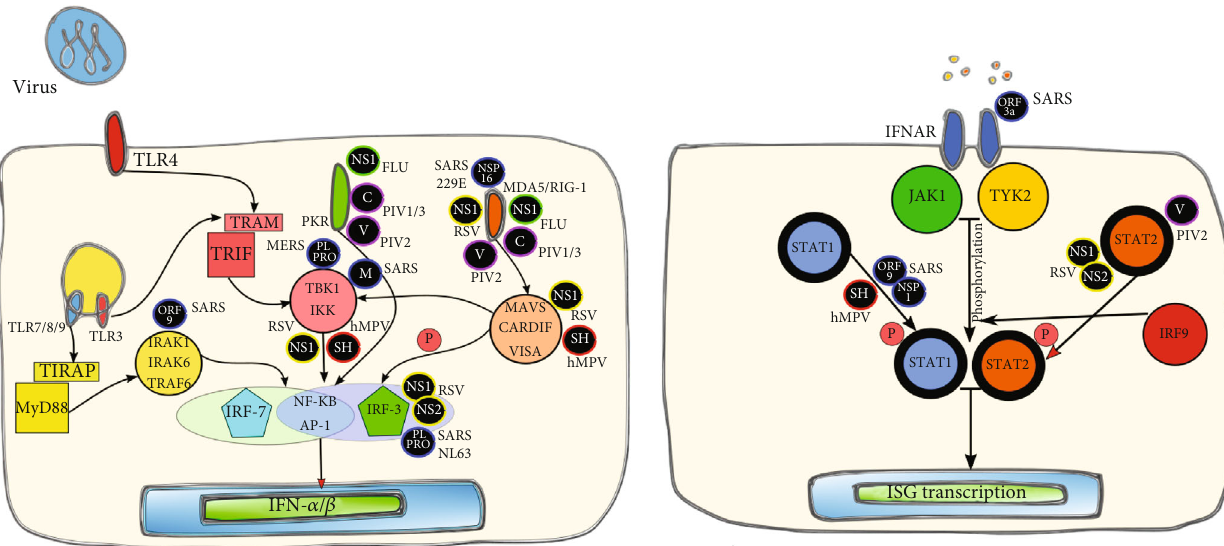
Figure 3: Evasion and inhibition of respiratory virus-induced IFN-I signaling. Many respiratory viruses can inhibit and modulate their detection using diverse strategies, thereby inhibiting the IFN-I production. Circular boxes in black background represent the viral protein involved in the pathway inhibition. Abbreviations: NS: nonstructural protein; V: V protein; C: C protein; SH: small hydrophobic protein.